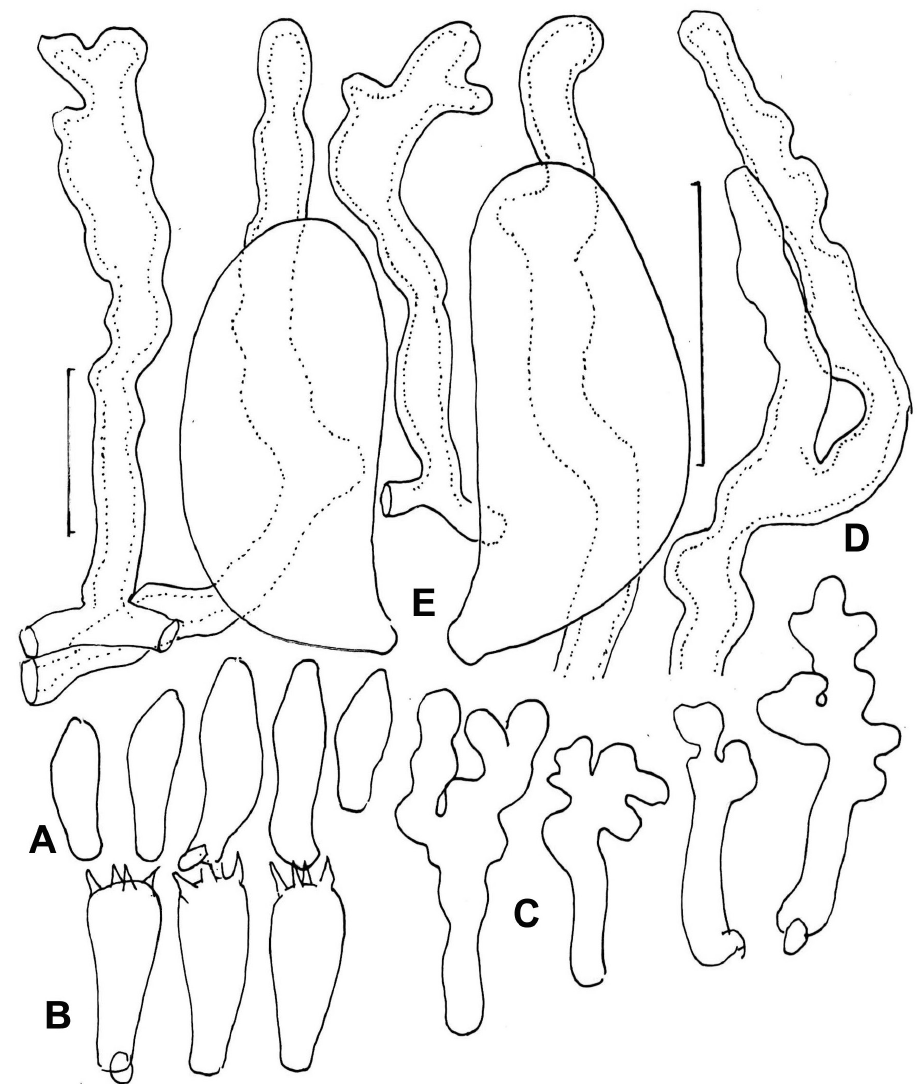
Figure 91. Mycetinis yunnanensis . Microstructures. A Pleurocystidia B Basidia C Cheilocystidia D Cau- locystidia E Basidiospores. Standard bars: A–D = 10 µm. E = 5 µm. TFB 3103